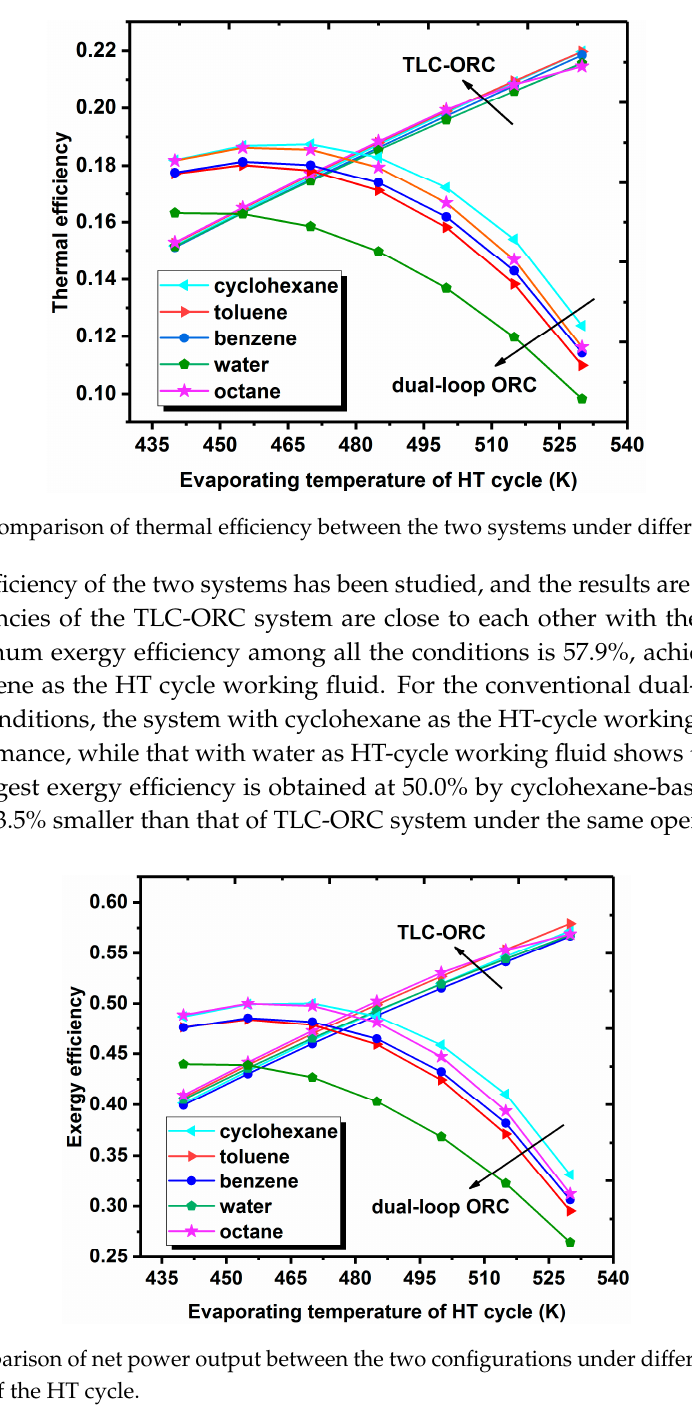
Figure 7. Comparison of net power output between the two configurations under different evaporating temperatures of the HT cycle.